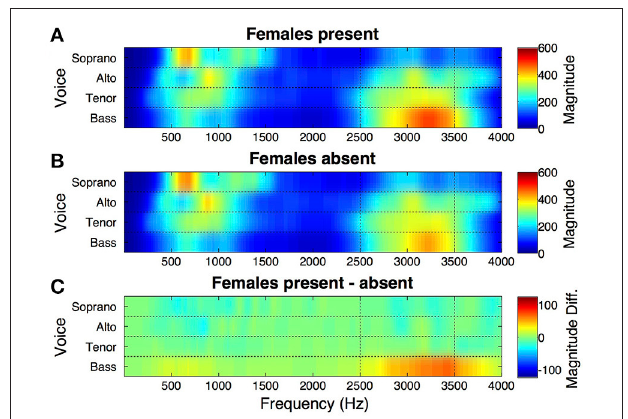
FIGURE 1 | Effect of female presence on spectral energy in male voices singing in chorus. (A) Time-averaged spectra for choir voice sections singing with adolescent females present in the audience. Output of the Terhardt outer ear model (see Section Spectral Energy) is shown for audio signal inputs at frequencies up to 4,000 Hz in sopranos, altos, tenors, and basses. Audio was recorded with individual head-worn microphones as the choir performed two distinctive pieces. Mean spectral magnitude is shown for each voice section (4 singers per section), averaged across the two pieces. There is a relatively high peak in energy in the singer’s formant region (2,500–3,500Hz) for basses. (B) Average spectra for voices when singing the same pieces to a male audience with females absent. The energy peak in basses in the singer’s formant region is weaker than when females were present. (C) The difference between spectral magnitudes when females were present vs. absent, highlighting the singer’s formant increase in